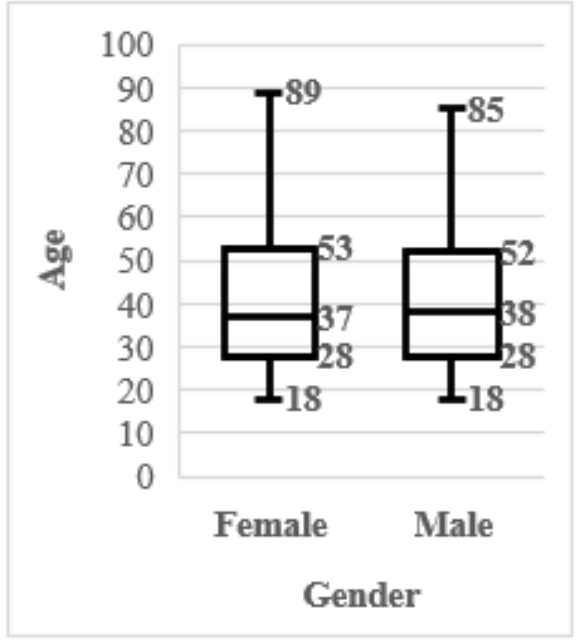
Figure 2. Sampled variables distribution. Ages within gender.